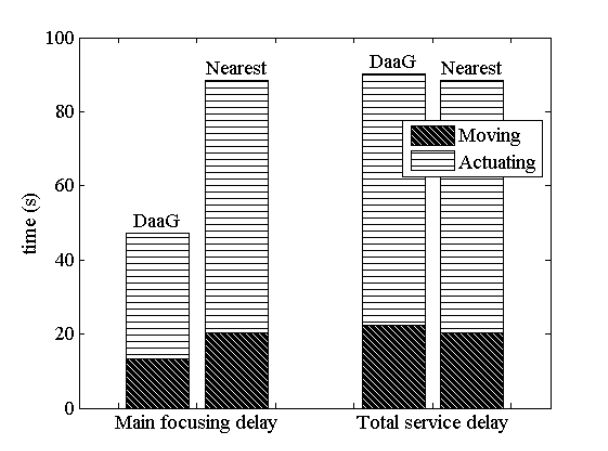
Figure 12. Delay measurement from the